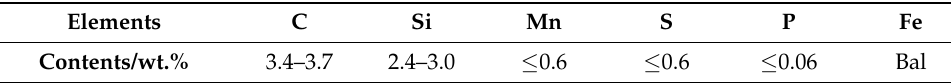
Table 2. Elemental composition of the compacted graphite